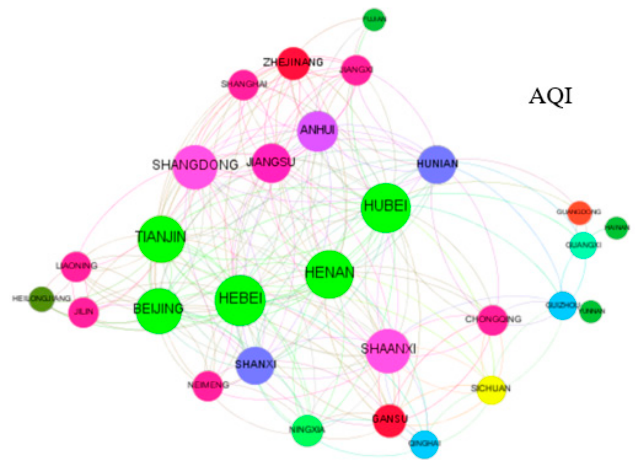
Figure 1. AQI spatial correlation network in 2014.